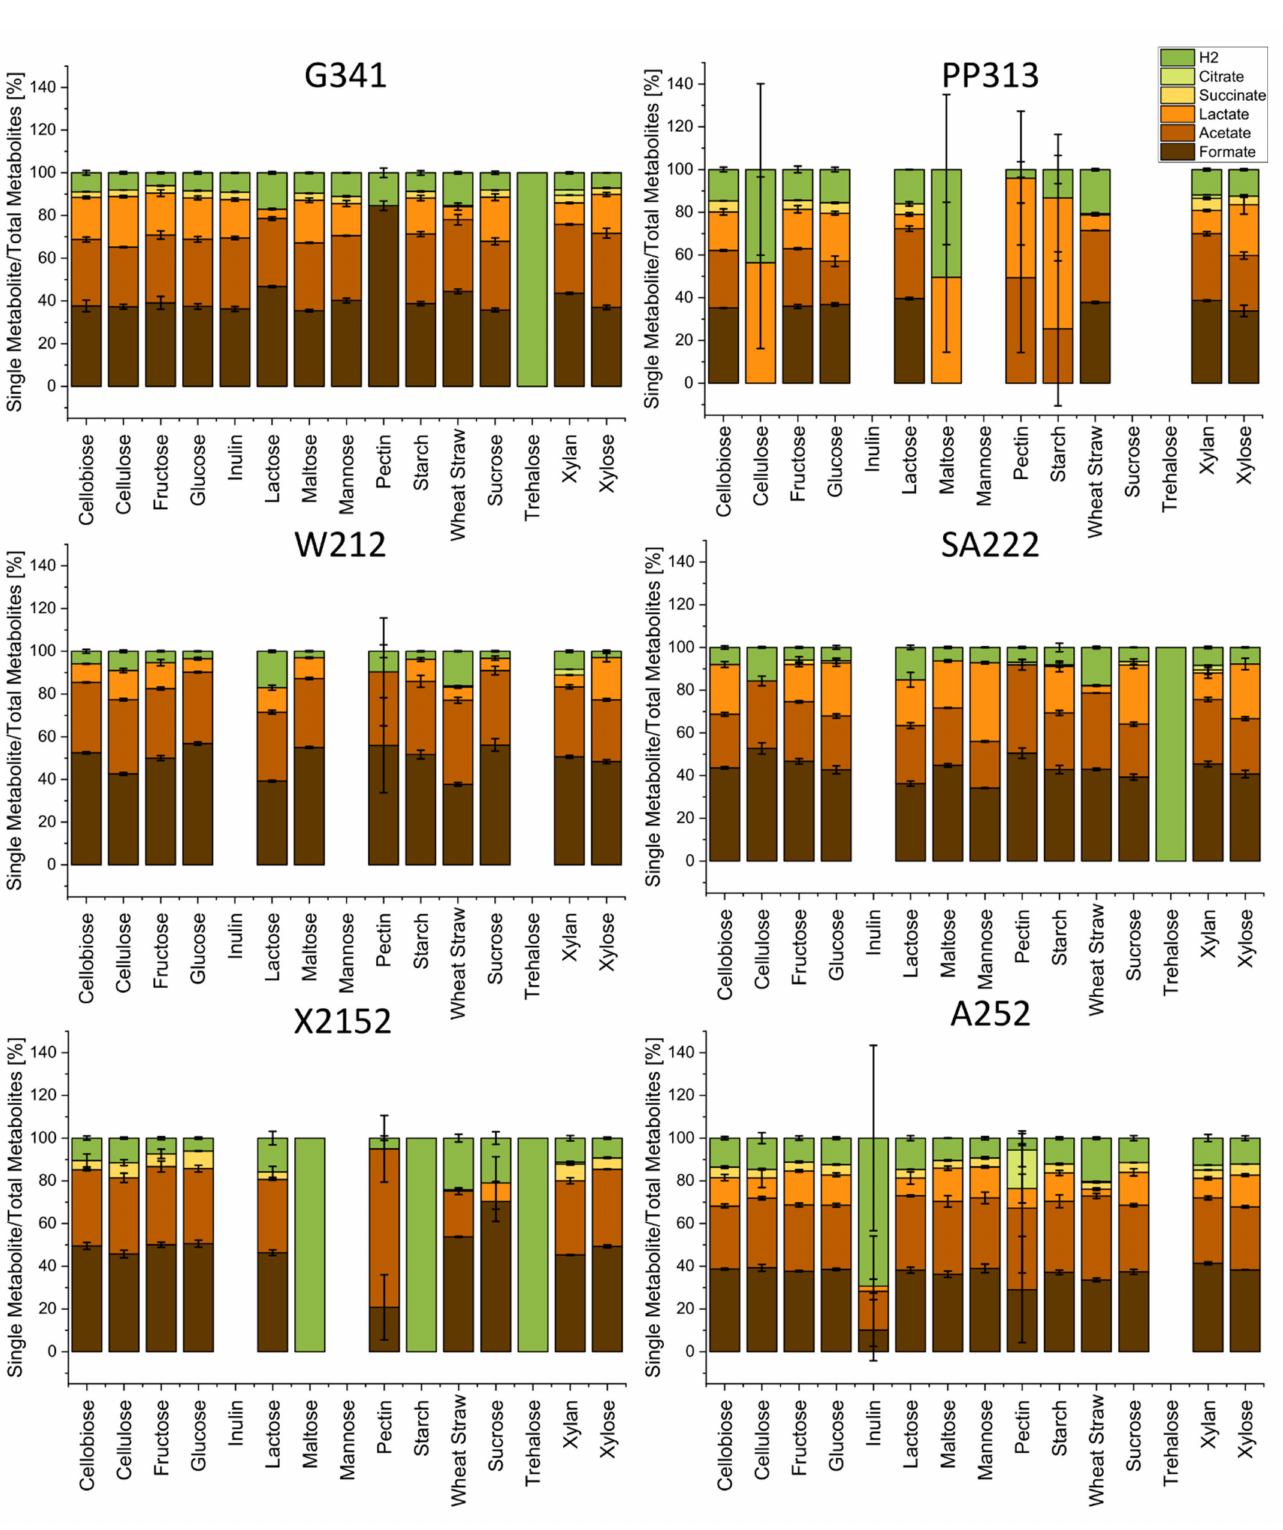
Figure 3. Relative amount of each produced metabolite when compared to the total of produced metabolites (%) of the strains G341, PP313, W212, SA222, X2152, and A252 during growth on different C-sources. Ethanol is excluded. Values shown represent averages of triplicate experiments and standard